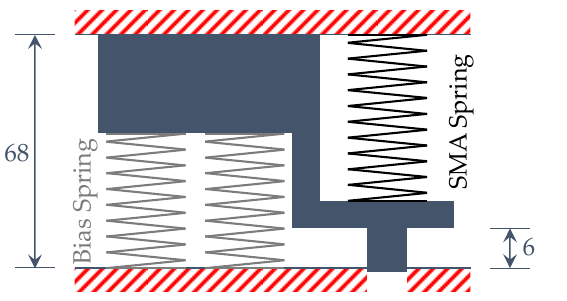
Figure 16. Geometrical arrangement and description of the investigated actuator (dimensions in mm).